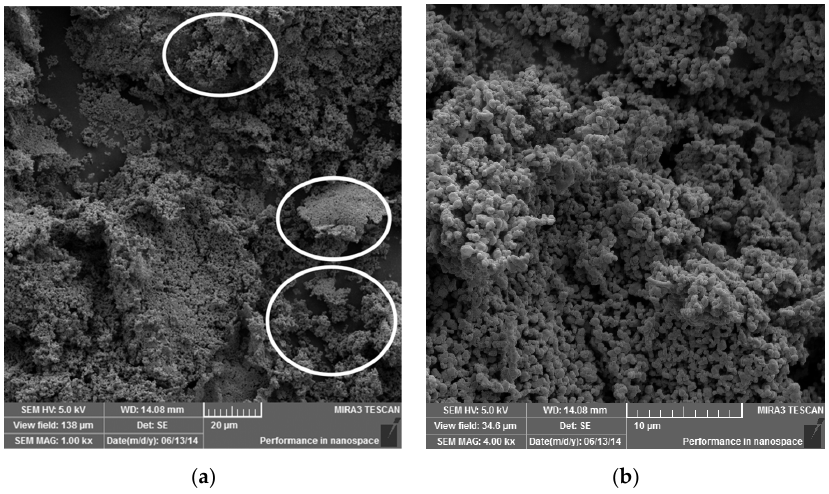
Figure 6. SEM–FEG images of composite PVA/Ag obtained by mechanical alloying. In ( a ), some flakes of PVA are highlighted with white circles, which are impregnated with Ag that can be better observed in ( b ) with higher magnification.